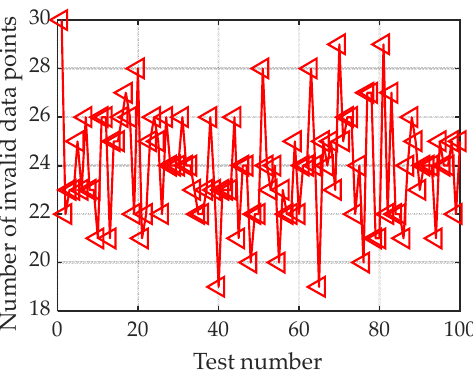
Figure 11. Statistical results of the number of invalid data points.